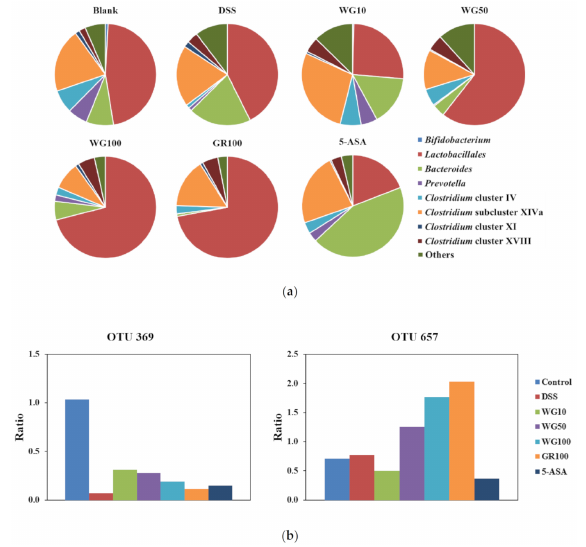
Figure 7. Stool sample microbiota from mice with DSS-induced ulcerative colitis, supplemented with or without WG and GR. ( a ) The relative abundance of bacteria in the stool was determined using terminal restriction fragment length polymorphism (T-RFLP) analysis. Data are shown as a percentage of the total identified sequences per group. ( b ) Effect of WG and GR on the ratio of operational taxonomic units (OTUs) before and after intervention with DSS, WG, GR, and